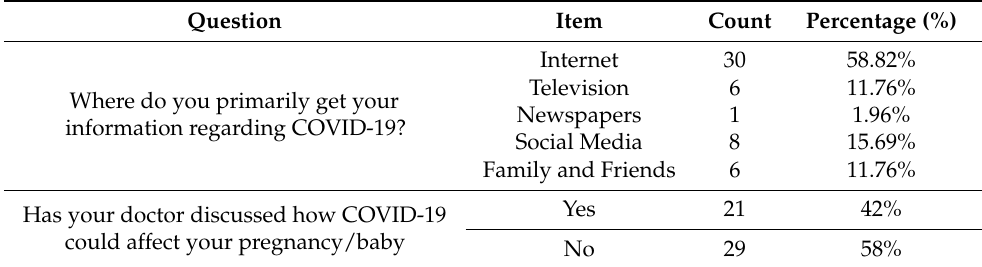
Table 2. Knowledge Regarding COVID-19.